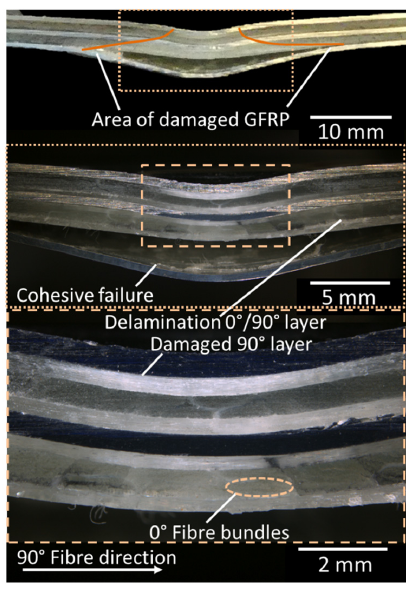
Figure 11. Microscopic cross ‐ sectional view of the 60 J impacted specimen at three different magnifications.